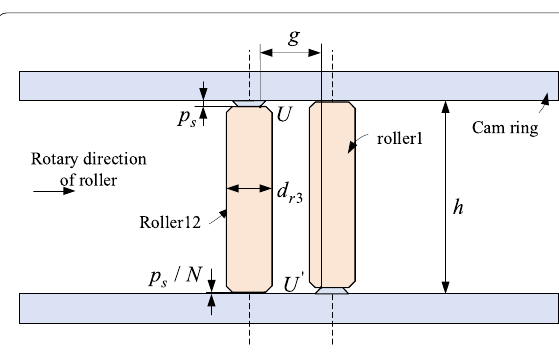
Figure 18 Both screw and nut are